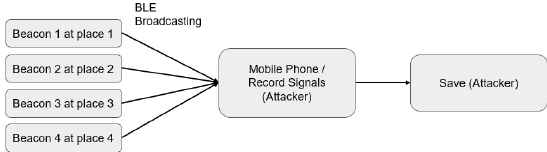
Figure 7. Normal iBeacon codes recorded and stored by hackers.